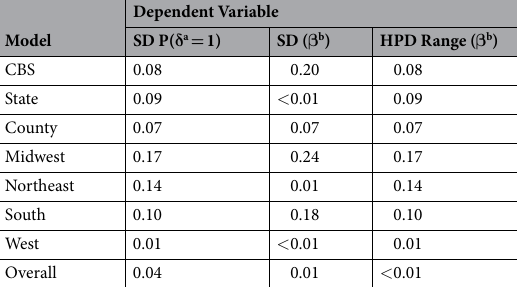
Table 3. R 2 statistics for linear models between the variance of predictor point estimates and the variance in posterior support metrics. a Inclusion probability. b Regression